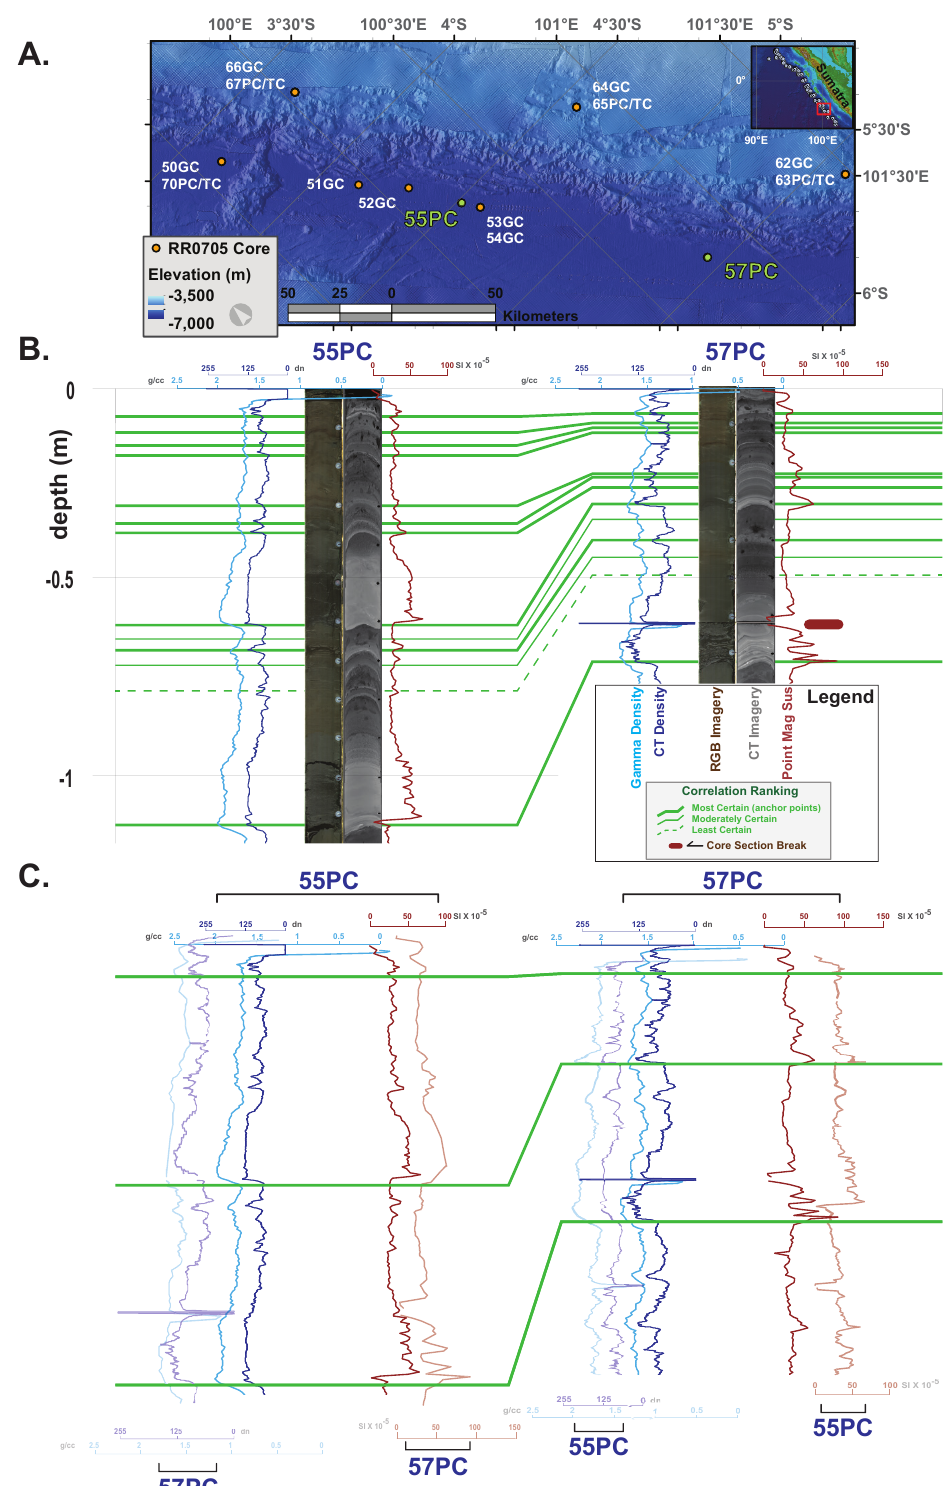
Fig. 4. Correlation of sedimentary units using standard stratigraphic correlation techniques between cores RR0705-55PC and RR0705-57PC. (A) Bathymetric map with cores plotted as brown dots and depth contours with 500m spacing. Cores 55PC and 57 PC are located in the trench approximately 120km from each other. (B) Stratigraphic correlations between these cores using lithology, CT, and geophysical properties. Multi Sensor Core Log (MSCL) data are plotted beside RGB imagery and CT imagery that displays lower density material in darker grey and higher density material in lighter grey. Gamma density, CT density, point magnetic susceptibility, and loop magnetic susceptibility are plotted left to right as light blue, dark blue, dark red, and light red. The relative certainty of any individual correlation is ranked and designated by line symbology. (C) MSCL data for core 57PC is “flattened” to stratigraphic horizons in core 55PC on the left, and 55PC is flattened to 57PC on the right. The core data being flattened is partially transparent and plotted on the outside of the core data they are being flattened to (known as “ghost tracing”). The unflattened core data are scaled at the same vertical scale as in (B)